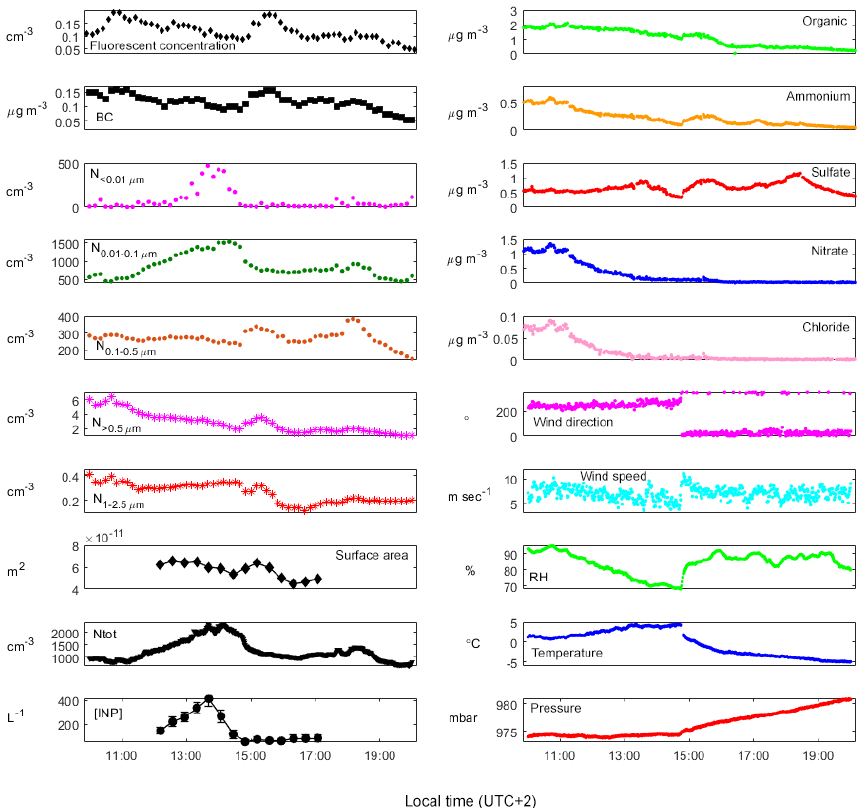
Figure 7. Time series of the [INP] and other parameters on 25 March 2018. Each panel is labelled with the parameter it shows, and the corresponding units are located adjacent to the relevant